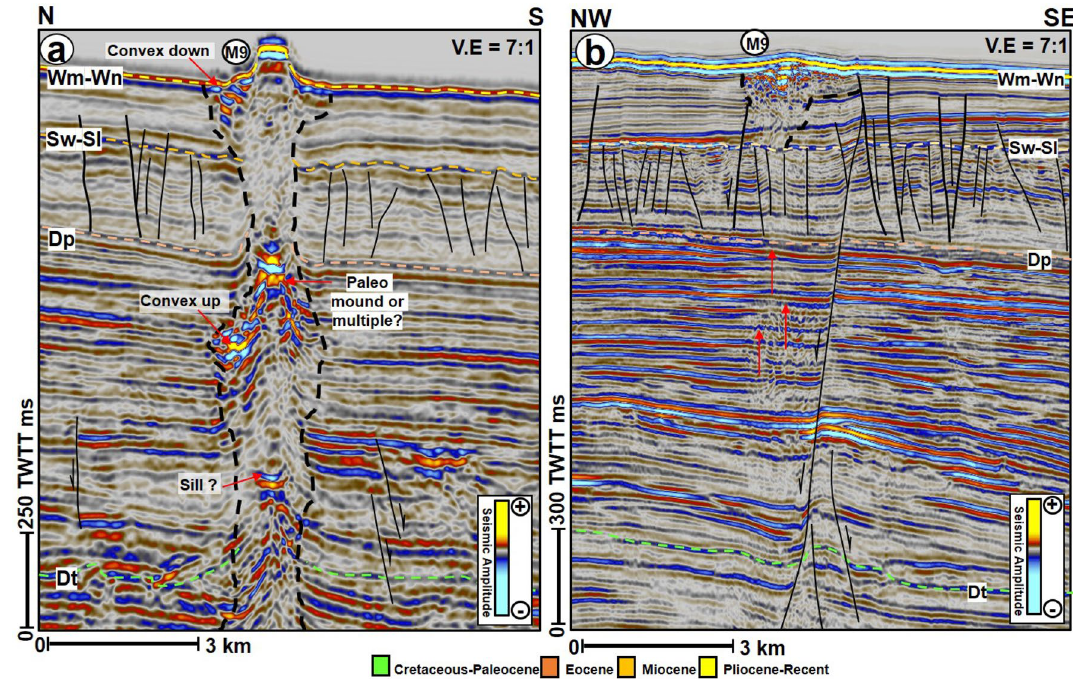
Figure 6. ( a ) N-S seismic profile through mound, M9 showing the vertical succession of mounds within the underlying escape pipe and interaction with magmatic sill at depth and ( b ) NW–SE seismic profile showing the connection between M9, polygonal faults and a deep-seated normal fault. TWTT: Two-way travel time in milliseconds. The uninterpreted seismic sections are provided in the supplementary document Volcanoes and intrusive rocks. Volcanoes in the study area include an edifice in the NE part of the seis- mic surveys (Figs. 1b and 10a). This edifice is interpreted as the domal structure of the Tuatara Volcanic Field 32 . On its flanks, several lateral and vertical stacks of high amplitude reflections are interpreted as associated lava flows (the horizontal ones) or intrusive rocks (the near saucer-shaped reflections). Volcanoes interpreted around the Tuatara Volcanic edifice are typically cone-shaped and on the SW of the edifice are strongly intersected by normal faults (Fig. 10a). Importantly, the main cone-shaped volcanoes adjacent to the edifice are buried within the Palaeocene strata, while the lava flows and smaller volcanoes are interpreted within the Eocene interval (Fig. 10a). A classic association of vertical and lateral stack of cone-shaped volcanoes is interpreted north of the Tuatara Volcanic Field (Fig. 10b). These buried volcanoes are present at three different stratigraphic intervals i.e., Palaeocene, Eocene, and Miocene (Fig. 10b), signifying a prolonged history of volcanism in the study area from the Palaeocene to Miocene. Volcanoes associated with the Miocene and Pleistocene units are also mapped directly beneath the present-day seabed, close to the seafloor mounds (Figs. 1b, and 10c). Additionally, intrusive rocks in the GSB (Figs. 3 and 10) often intersect the basement unit and sometimes are present on both the foot- wall and hanging wall sections of some of the deep-seated faults (Fig. 3a,b). Those associated with the volcanoes are found in two main domains, defined as the western domain comprising patches of intrusive fields and an eastern domain composed of two isolated intrusive fields in Fig. 1b. These two domains run essentially NE-SW with the western domain extending south and subjacent to the mapped seafloor mounds (Fig. 1b). Importantly, one of the intrusive fields is mapped close to the Toroa wellbore. This may correspond to the Toroa volcanic field